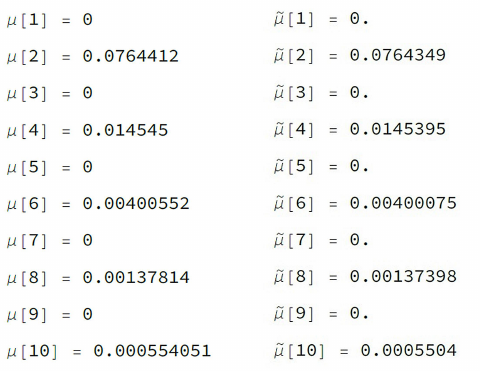
Figure 12. Moments of F ( t ) in (30) as computed using the G-KQR ( left ) and the proposed Bell’s polynomial approximation ( right ) methods.